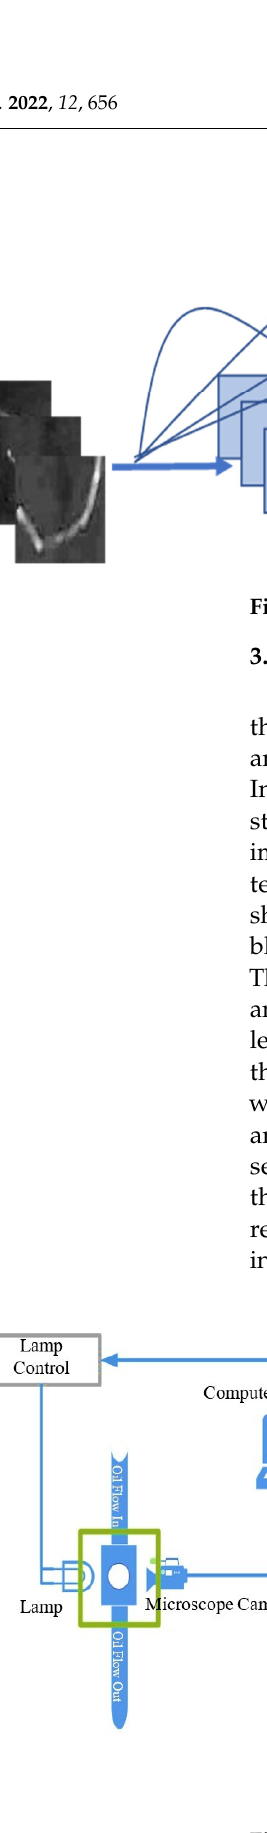
Figure 5. Object image acquisition in coconut